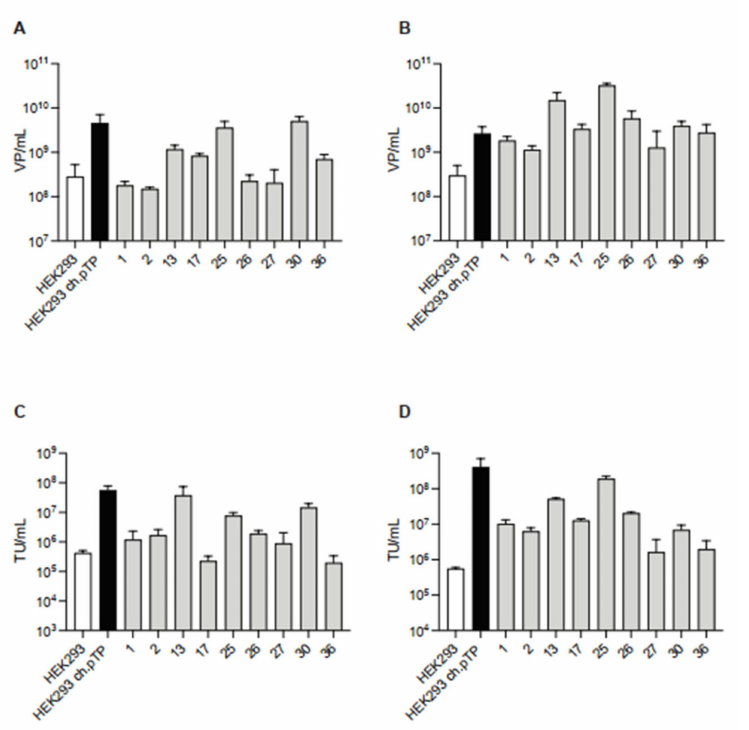
Figure 4. ChAd-C vector produced in HEK293ch.pTP clones. Titration of chAd-C Venus vec- tor in terms of VP/mL and TU/mL rescued (P0, ( A , C )) and propagated (P1, ( B , D )) in HEK293, HEK293ch.pTP cells and nine isolated clones. Mean with standard deviation ( n = 2) is